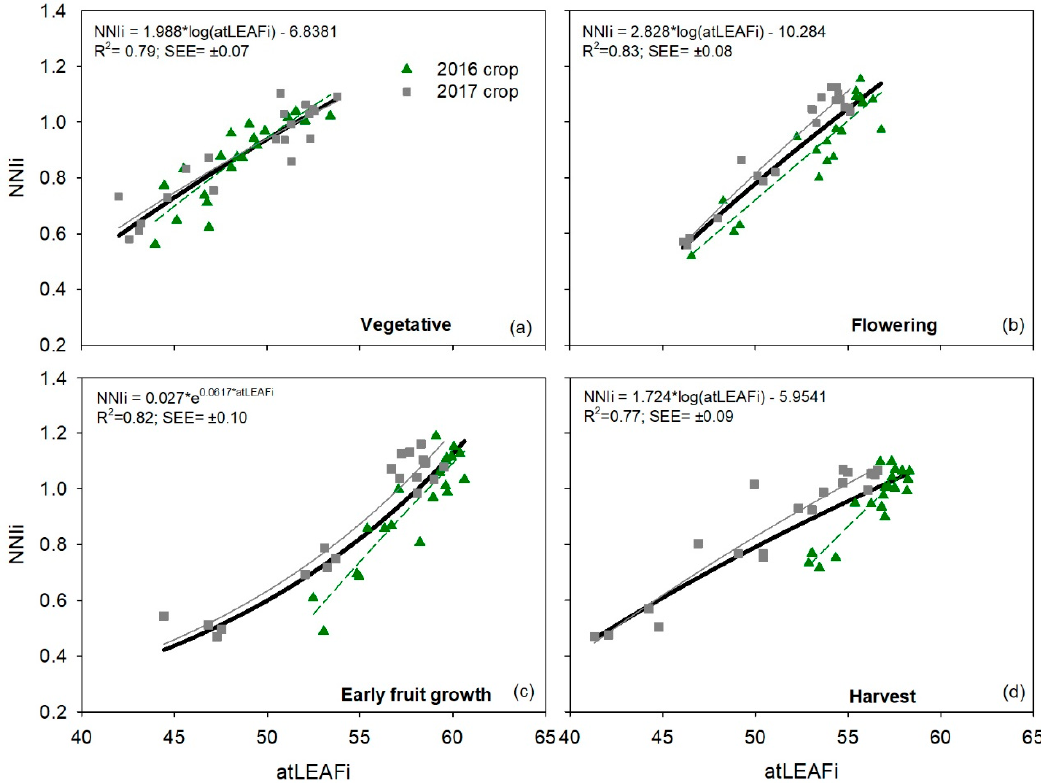
Figure 4. Relationships between integrated atLEAF ( atLEAFi ) values and the integrated crop nitrogen nutrition index ( NNIi ) for each phenological stage in each of the two sweet pepper ( Capsicum annuum ) crops. Each crop was subjected to five different N treatments with four repetitions. The bold black line and the equation represent the adjustment for the combined dataset of the two crops together. Results of regression for each crop separately are in Table 7.